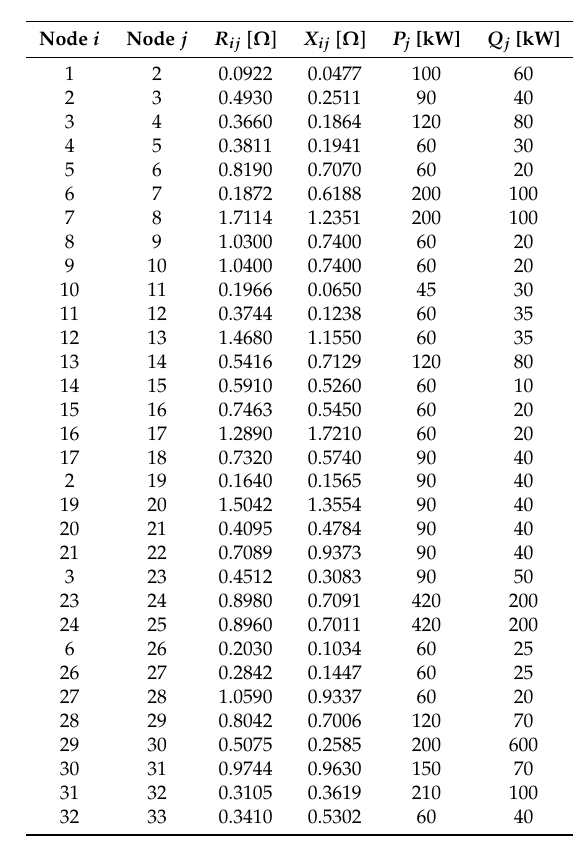
Table 1. Branches and loads information for the 33-nodes test feeder.